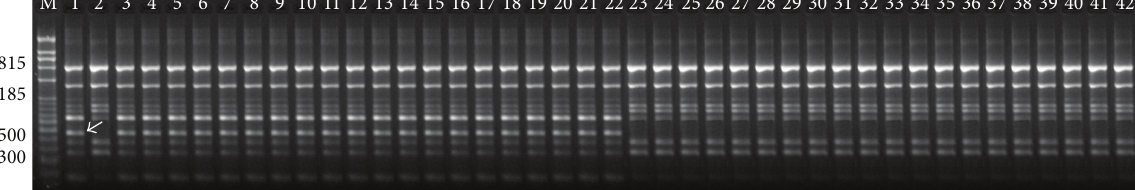
Figure 2: ISSR banding patterns of male and female plants of Trichosanthes dioica obtained with the primer ISSR-6 (5 󸀠 - GACAGACAGACAGACA-3 󸀠 ). The arrow indicates the unique band of ∼ 550 bp present in the male bulk. lane 1, bulk male; lane 2, bulk female; lanes 3–22, male individuals; lanes 23–42, female individuals; M denotes molecular mass marker (100bp